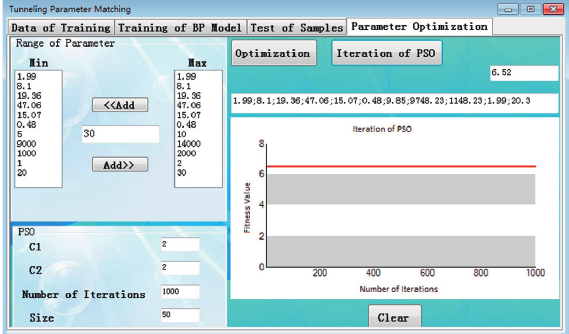
Figure 7: The interface of the parameter optimization based on PSO. Table 6: Optimization results based on BP and